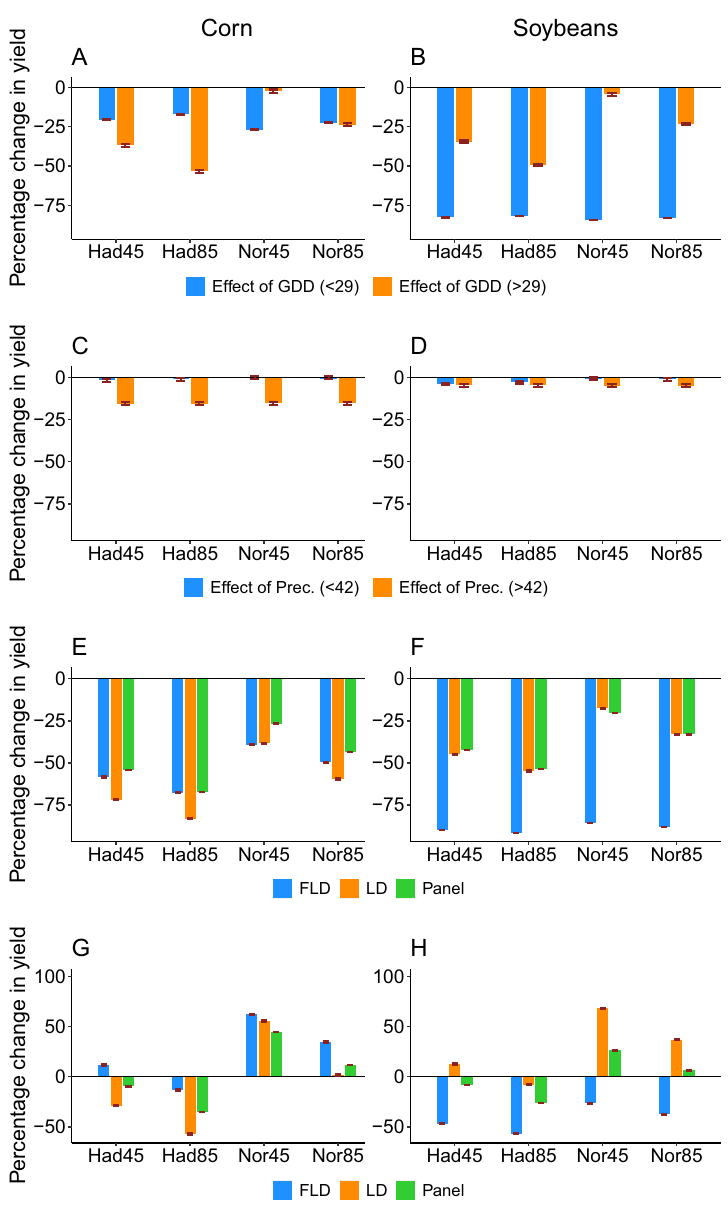
Figure 4. Projected future change of crop yields by 2050. Notes : Had45 is the abbreviation for the climate model HadGEM2-ES365 with warming scenario RCP 4.5. Similar interpretation applies to Had85, Nor45, and Nor85, where ‘Nor’ stands for global climate model NorESM1-M. FLD stands for the flexible long differences approach, LD for the long differences approach, and Panel for the fixed effects panel approach. The length of a bar represents the level of the predicted percentage change in yield and the whiskers are the 95% confidence intervals of the prediction. Graphs A and B show the projections using only temperature changes. Graphs C and D show the projections using only precipitation changes. Graphs E and F show the projected yield change caused by overall climate change under three model specifications: Flexible long differences (FLD) model, long differences (LD) model, and fixed effects panel data model (Panel). Graphs G and H show the overall projected yield change caused by climate change and by climate-neutral technological improvement under the aforementioned three model specifications. Graphs A, C, E and G are for corn yield and Graphs B, D, F and H are for soybean yield. We assume that the adaptation and the annual rate for climate-neutral technical change from 2015 to 2050 are the same as that from 1960 to